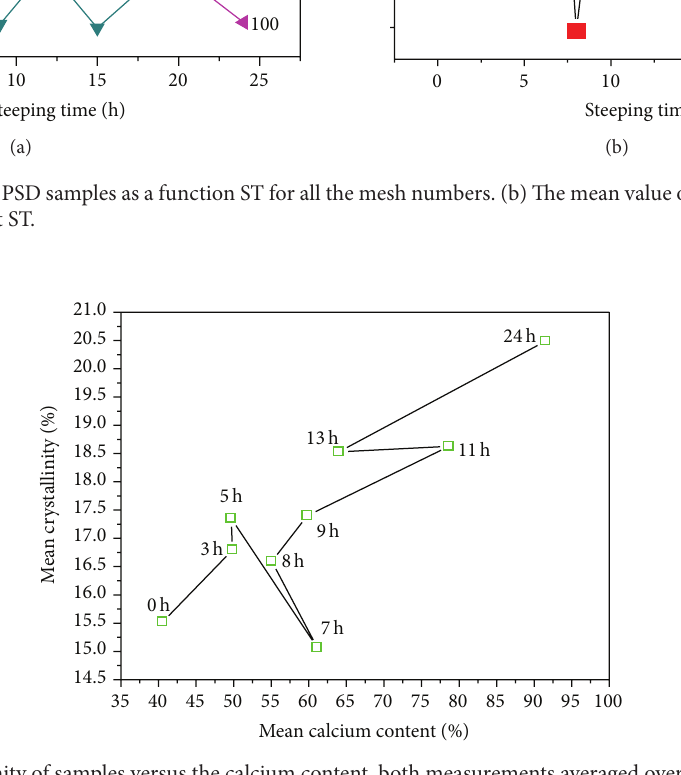
Figure 6: The crystallinity of samples versus the calcium content, both measurements averaged over the twelve ST